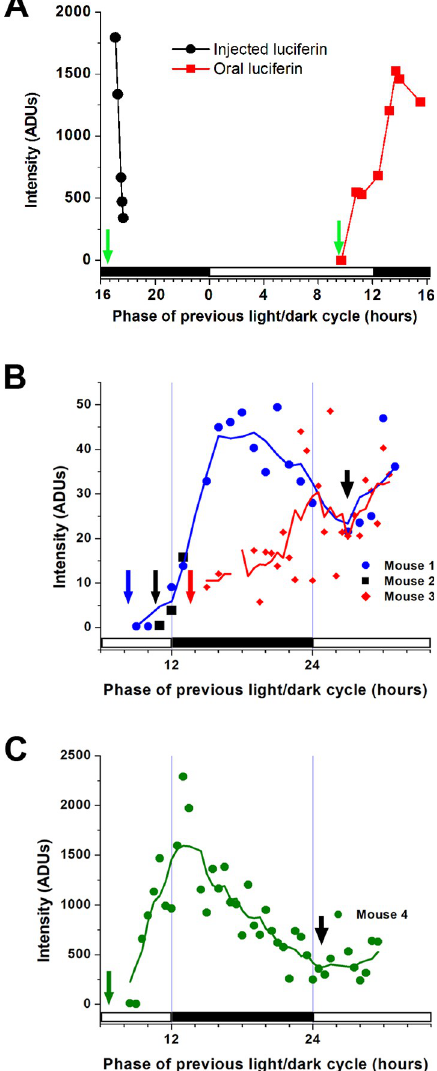
Fig 3. Enhanced bioluminescence signal stability following oral versus injected luciferin delivery. A: Average maximum signal from a freely moving female mouse imaged with the Evolve EMCCD camera after luciferin injection (first arrow) shows the predicted rapid decline over the next hour. The first point was adjusted to correct for different camera settings. Oral luciferin provided to the same mouse (second arrow) before the time when circadian activity begins, near projected dusk (hour 12), produced a rapid and sustained signal. Bars below show the light and dark phases of the light cycle before the recording. B: Average pixel intensity of three freely moving mice provided with oral luciferin at three time points around the end of the day (long arrows) and imaged with the non-EMCCD camera (CH360) and 60-minute exposures to integrate the signal. Luciferin delivered before projected dusk produced a rapid rise in signal in long (Mouse 1) and short (Mouse 2) recordings. Luciferin provided after projected dusk produced a slower increase in signal (Mouse 3) that converged with the level achieved by Mouse 1 including the dip in signal following projected dawn (short arrow). Shown is integrated whole animal bioluminescence without any selection for the posture of the mouse or its position within the field of view. C: A fourth mouse imaged with the non-EMCCD camera and provided with oral luciferin five hours below the projected night shows a similar temporal pattern of bioluminescence including the dip in signal after projected dawn. Lines in B and C are 5-point running